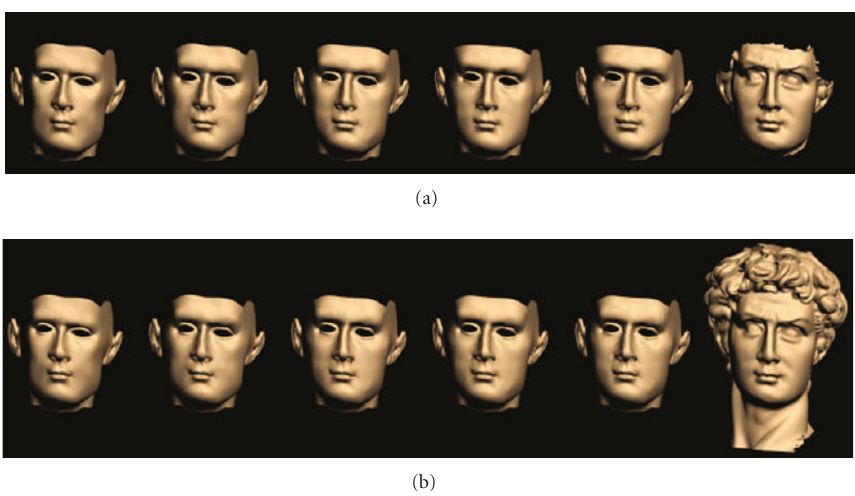
Figure 6: Comparison of adaption results between combination approach and RBF approach. (a) Combination approach; (b) RBF approach.